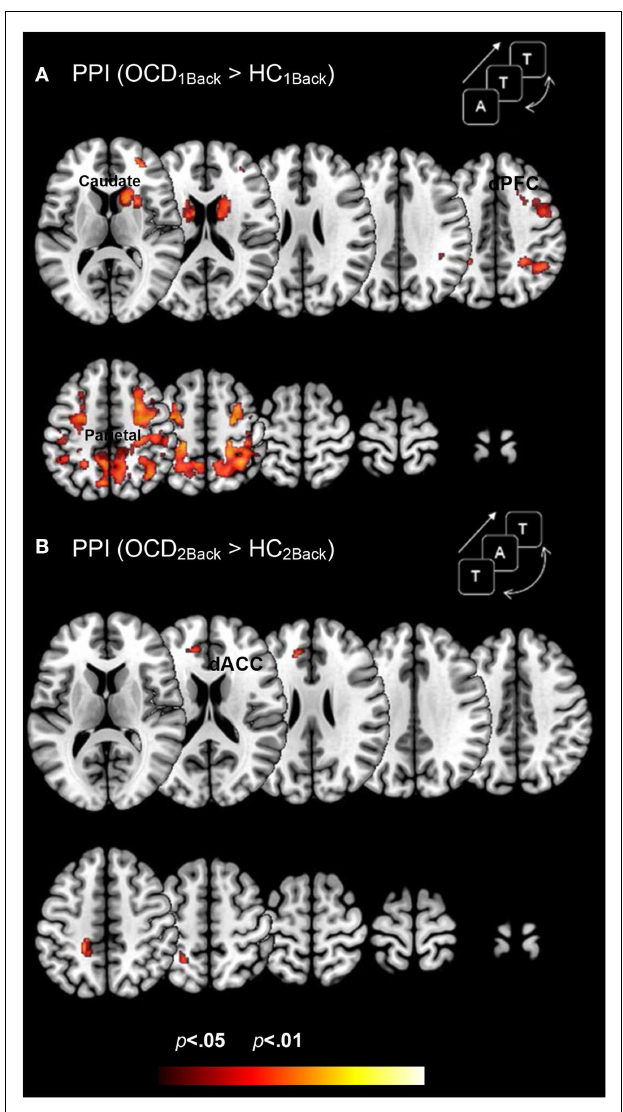
FIGURE 4 | Dysfunctional brain network profiles in OCD (relative to controls) are depicted for both (A) the 1Back level of memory and (B) the 2Back level of memory load .The clusters depict significantly increased dACC-modulation of cortical and striatal targets in OCD compared to typical controls ( p < 0.05, cluster level) depicted on identical ascending mosaics of axial views.These brain network profiles complement dysfunctional activation profiles ( Figure 3 ). Note the implication of the caudate, not implicated in dysfunctional activation.The increased modulation by the dACC may reflect increased control-related inputs demanded in OCD to sub-serve network function associated with this fundamental domain.The lack of a parametric effect may reflect the fact that dACC related network engagement is already aberrantly increased at the 1Back level. Indeed, OCD participants did not show an increase in dACC modulation going from the 1Back to the 2Back level of demand (whereas HC participants